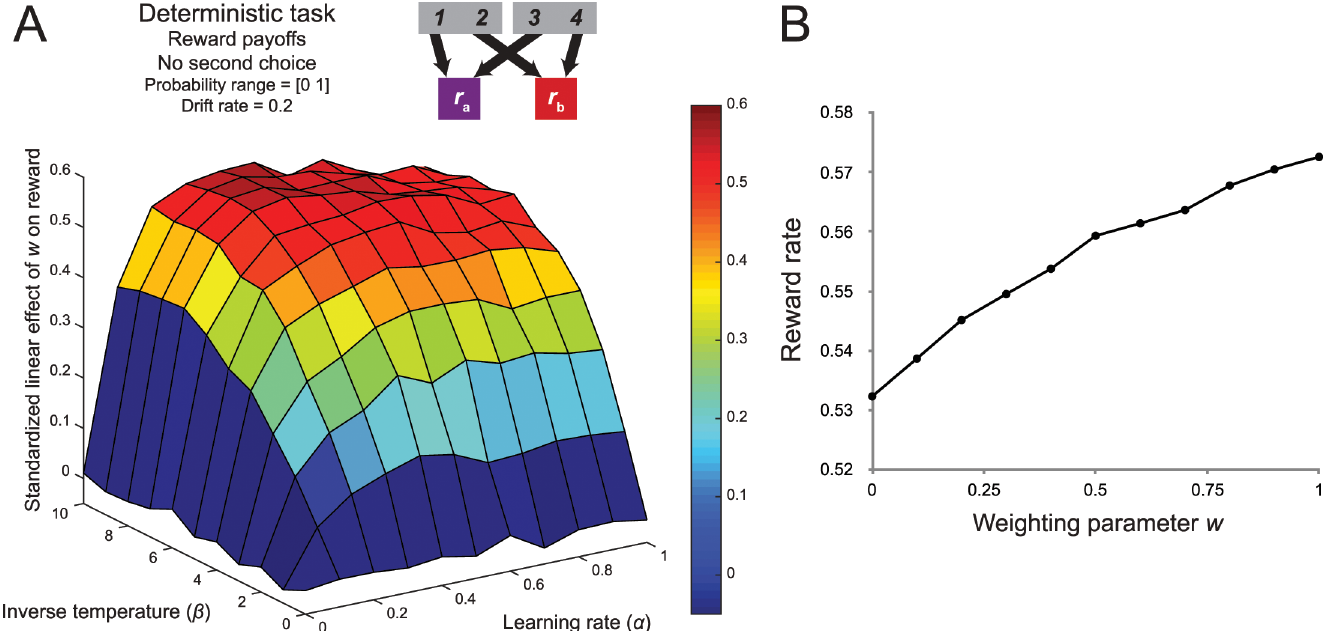
Fig 11. The influence of removing binomial noise from the reward distributions at the second stage. (A) The surface plot of the relationship between model-based control and reward in the novel two-step task with reward payoffs at the second stage. The inclusion of this fifth factor substantially increased the accuracy-demand trade-off in the two-step paradigm. (B) An example of the average relationship between the weighting parameter and reward rate with inverse temperature = 10 and α =